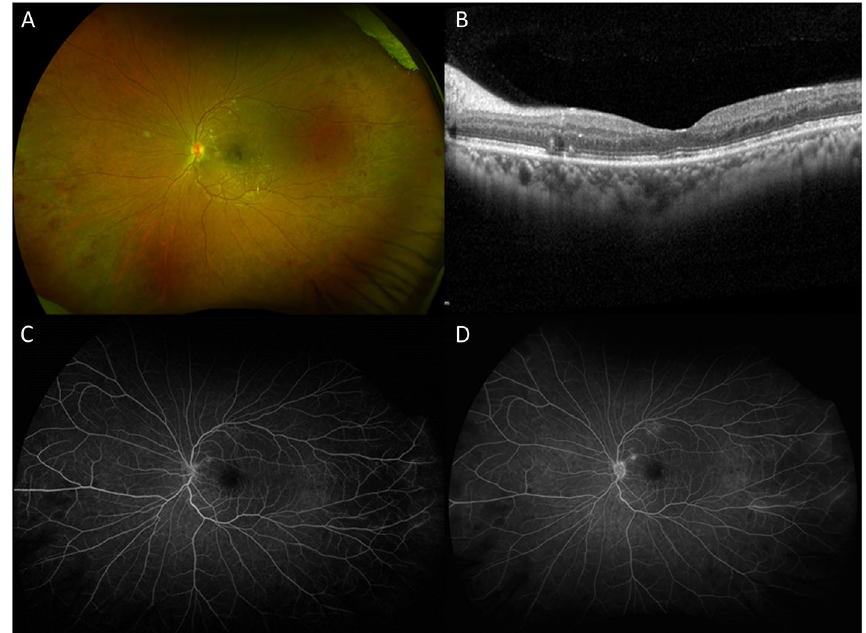
Fig. 3 Repeat evaluation 2-months after presentation and treatment initiation shows resolution of optic disc edema and improvement of retinal hemorrhages ( A ). Optical coherence tomography shows resolution of subretinal and intraretinal fluid with residual focal ellipsoid zone irregularities ( B ). There is near resolution of leakage on fluorescein angiogram with persistent but improved peripheral ischemia during mid-phase ( C ) and late frames ( D